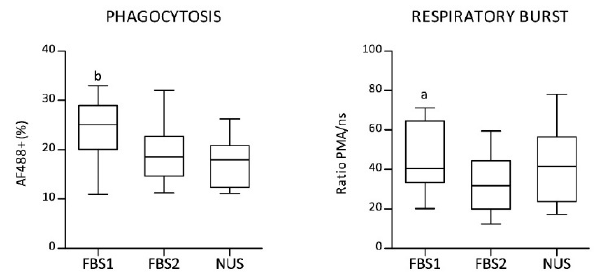
Figure 4. Phagocytic activity and respiratory burst. Phagocytic activity assessed by flow cytometry is presented as a percentage of MDMs positive for Alexa Fluor 488-conjugated (AF488 + ) opsonized zymosan A bioparticles. Respiratory burst measured by a chemiluminescence assay presented as the PMA-stimulated/unstimulated ratio of samples from integrals of chemiluminescence intensity. Boxplots represent data from the MDM culture with fetal bovine serum (FBS1 and FBS2) or with reduced-serum medium (NUS): median (line), first and third quartiles (box), and minimum and maximum (whiskers); n = 14 (phagocytosis), n = 15 (respiratory burst). Significant differences (Fried- man test with Dunn’s multiple-comparison post hoc test) between groups are marked as follows: a FBS1 vs. FBS2, p < 0.05; b FBS1 vs. NUS, p <